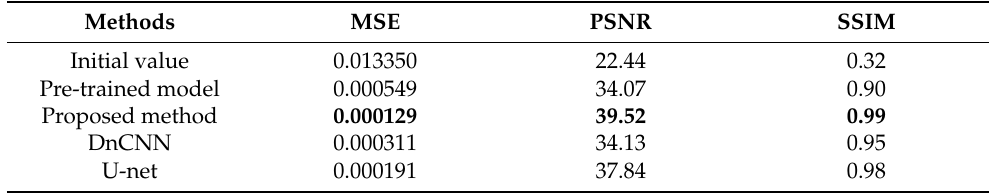
Table 4. Quantitative comparison of the second synthetic example.